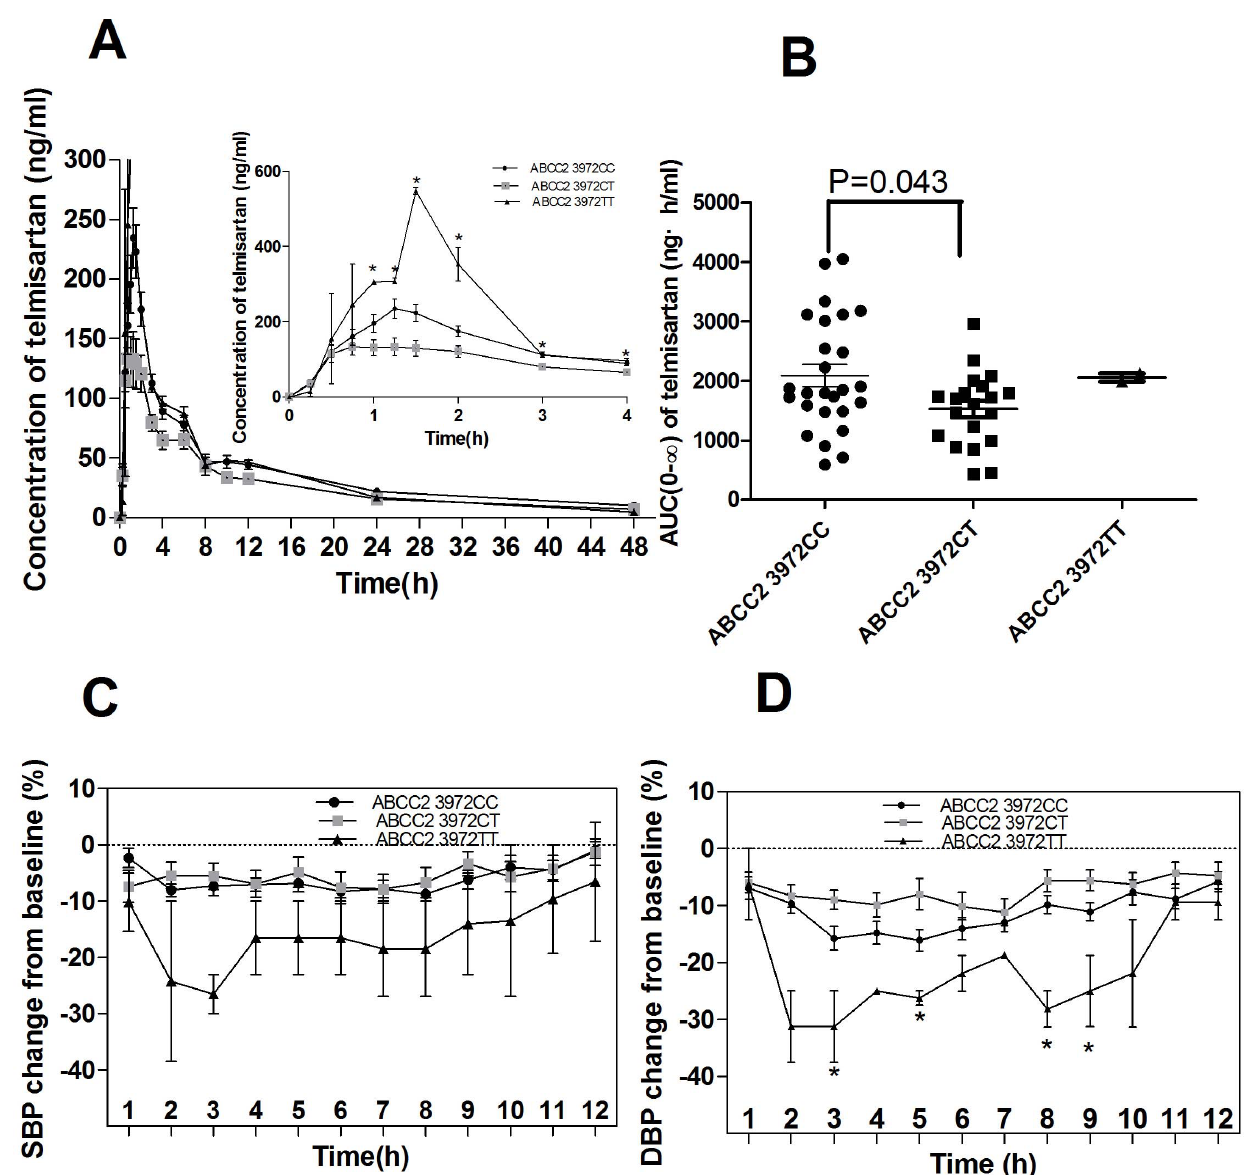
Figure 2. The impacts of ABCC2 genotypes on the PKs and BP change(%) after 40 mg telmisartan. A, Concentration; B, AUC (0– ‘ ) ; C, SBP change(%) from the baseline; D, DBP change(%) from the